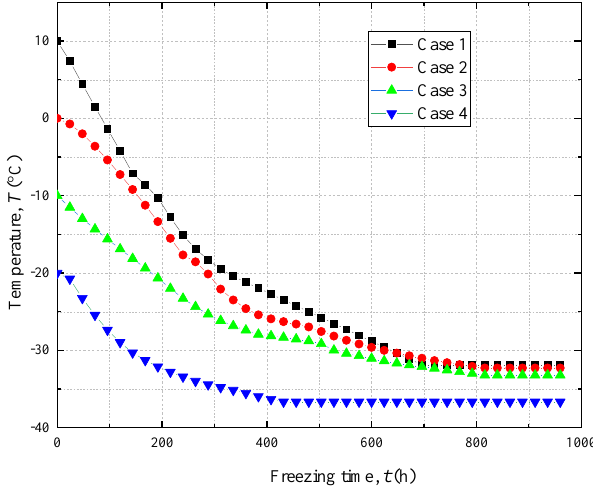
Figure 6. Temperature development at the observation point during freezing at different initial tem- peratures.